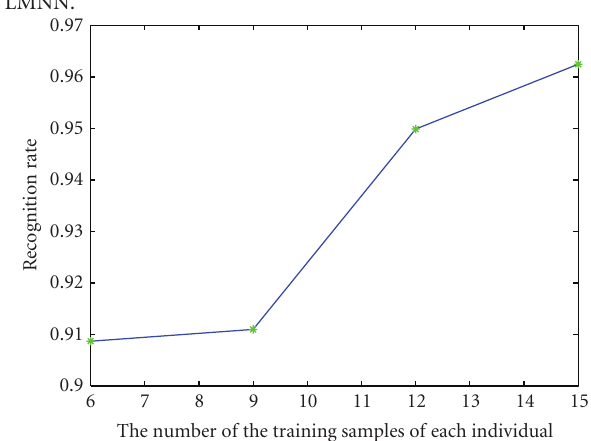
Figure 8: The recognition rates with di ff erent numbers of training